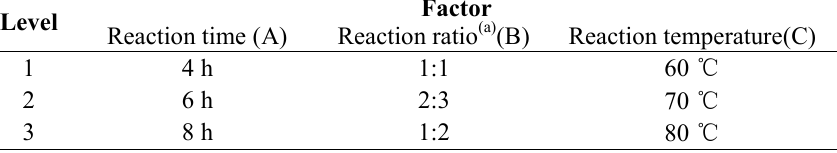
Table 1. Factors and levels of orthogonal experiment.